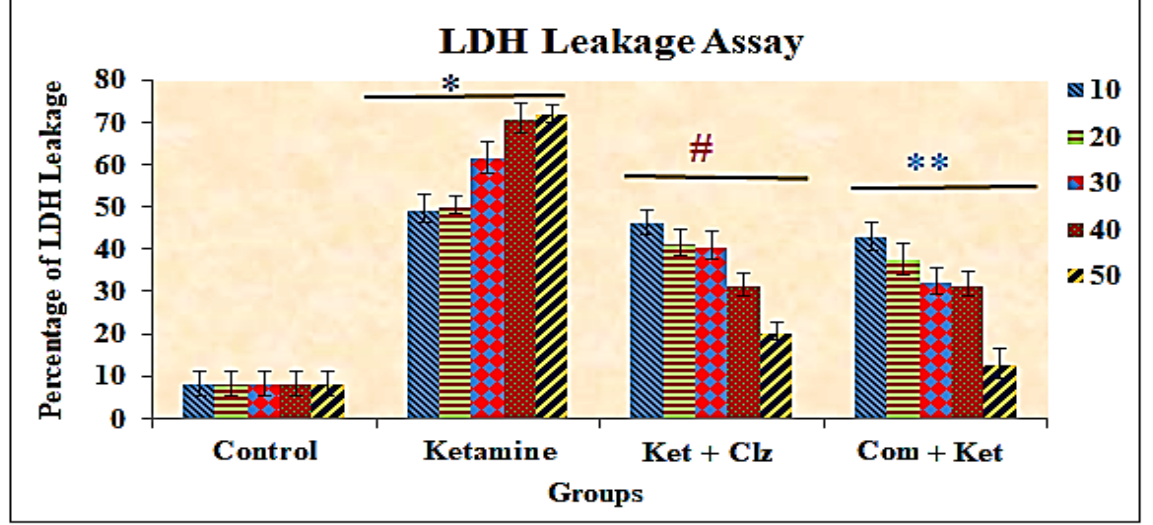
Figure 4. Protective effects of plant compound and clozapine on LDH activity in the culture medium of PC 12 cell lines treated with plant compound and clozapine. All the values are expressed as means ± SD of six individuals. * Significant at p < 0.05 compared with control; # and ** significant at p < 0.05 compared with ketamine treated group; 10 – 50: concentration in µg/mL of ketamine, clozapine, and compound.